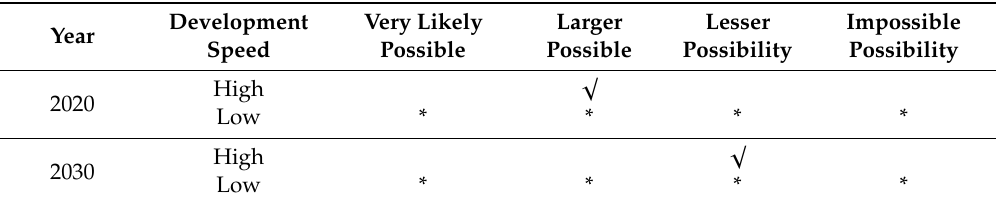
Table 4. Social economic development speed expert recommendation probability statistics table in 2020 and 2030. Please check the column that you think is possible.